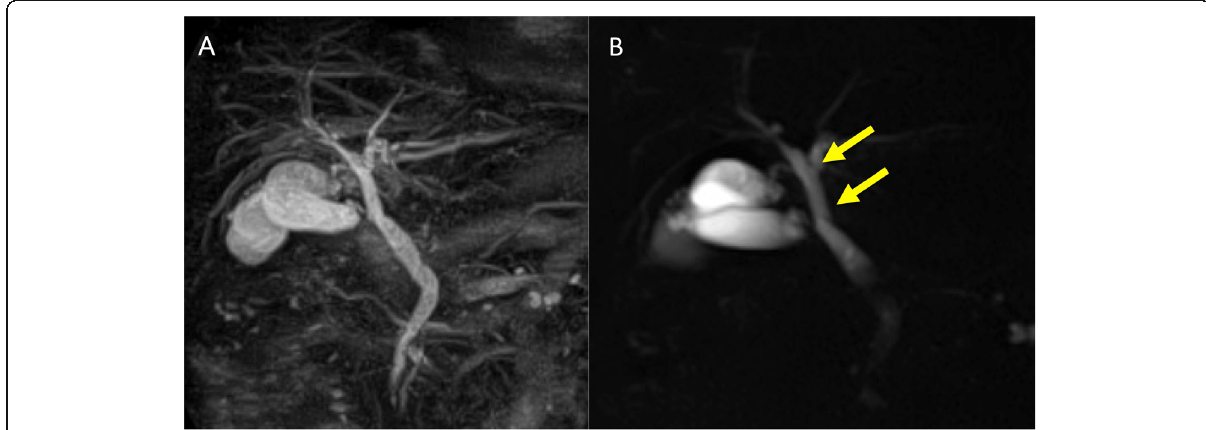
Fig. 3 MRCP imaging. a 3D image and b 2D image. A definite H-type duplicated gallbladder was demonstrated. Both cystic ducts were identified as diverging individually from the common bile duct (see the